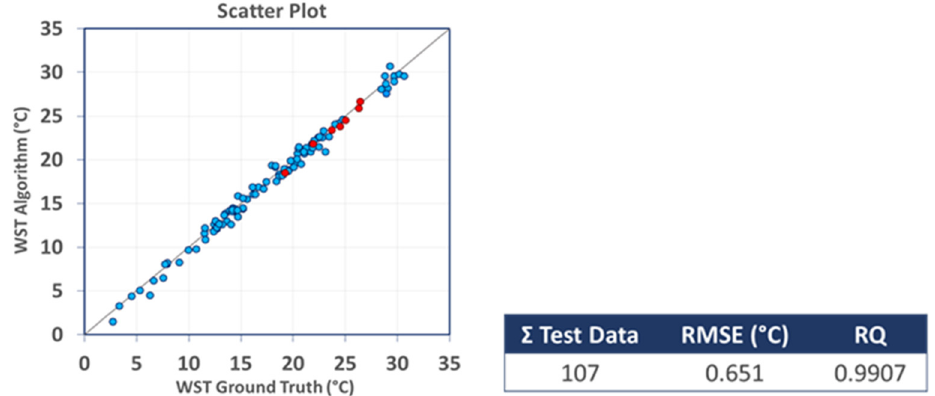
Figure 8. Scatter plot from the algorithm validation phase. Summary of the algorithm validation with root mean square error (RMSE), Pearson square coefficient (RQ) and the number of test data.